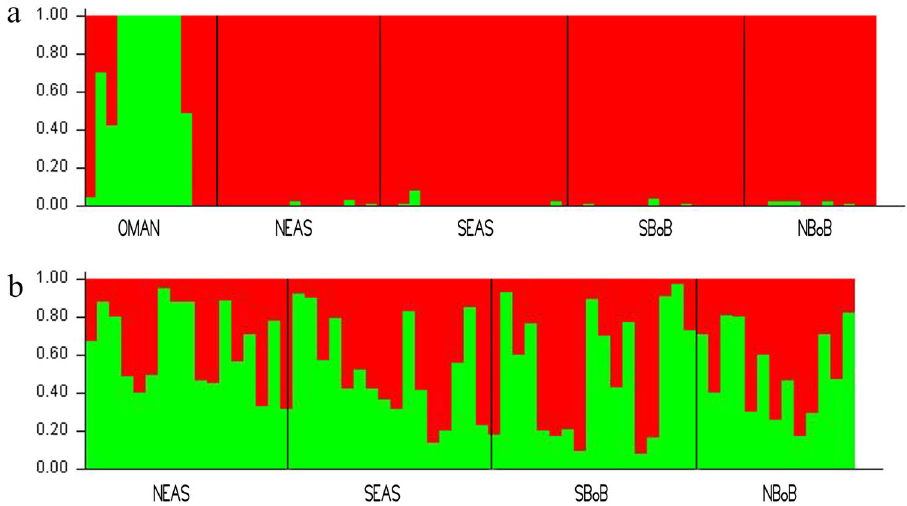
Figure 1. Graphical results of admixture analysis among all populations derived from 56,358 SNPs loci in STRU CTU RE. Vertical lines represent the probability of individual membership in simulated clusters. ( a ) Plot for K = 2 (including all the five samples), ( b ) plot for K = 2 (excluding OMAN samples). The plot was generated with STRU CTU RE v2.3 85